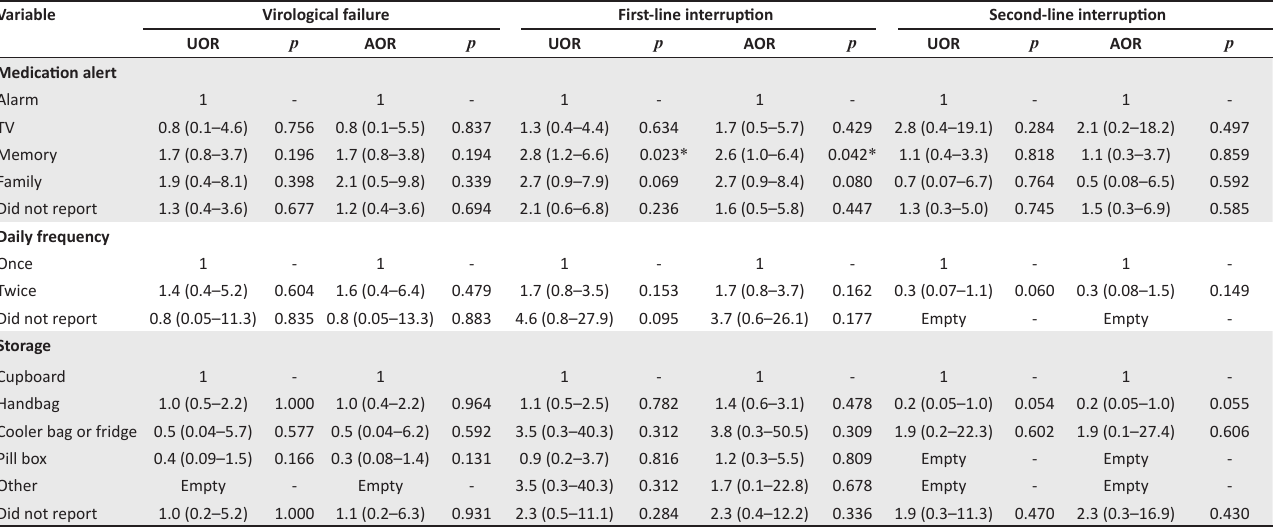
TABLE 4: Logistic regression analysis between virological failure, regimens (first-line and second-line regimen) and treatment-taking behaviour indicators in health facilities in Johannesburg inner city. Variable